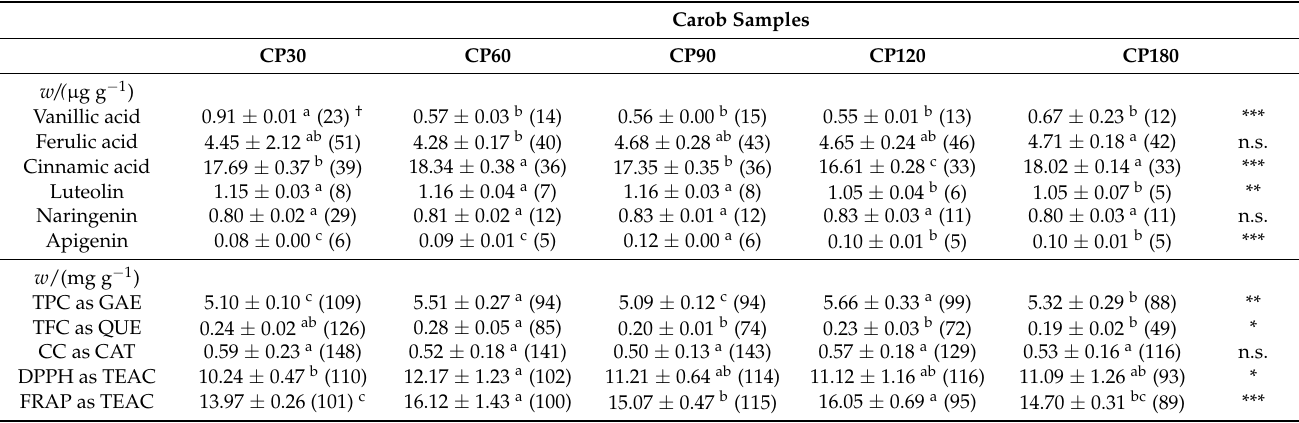
Table 3. Phenolic content and antioxidant properties of carob powder (CP) after in vitro digestion, and its